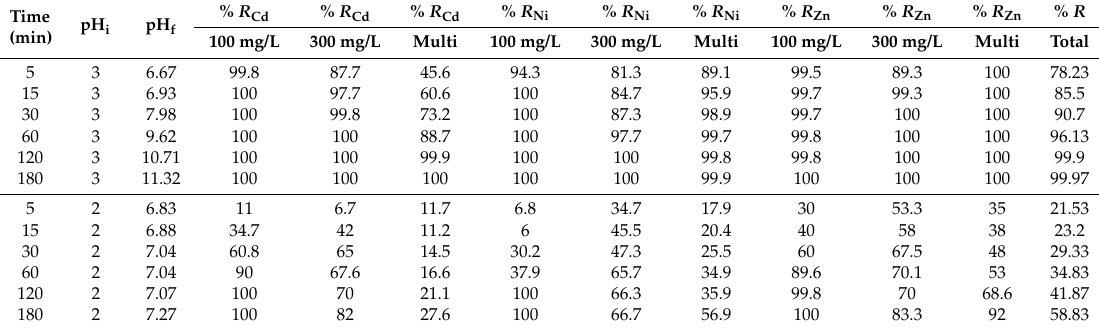
Table 5. Comparison of single and multi-component removal of Cd 2+ , Ni 2+ , and Zn 2+ by bottom ash. Time pH i pH (min)